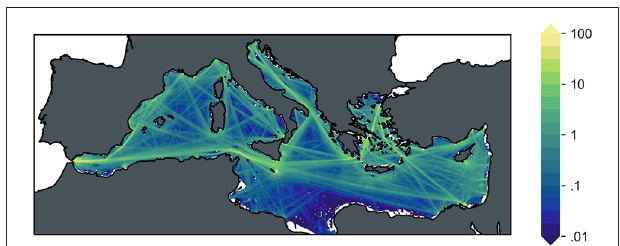
FIGURE 1 | Spatial distribution of annual slaked lime disposal over the Mediterranean basin for both alkalinization scenarios based on cargo and tanker shipping traffic. Discharge is given relative to the basin scale average, in a logarithmic